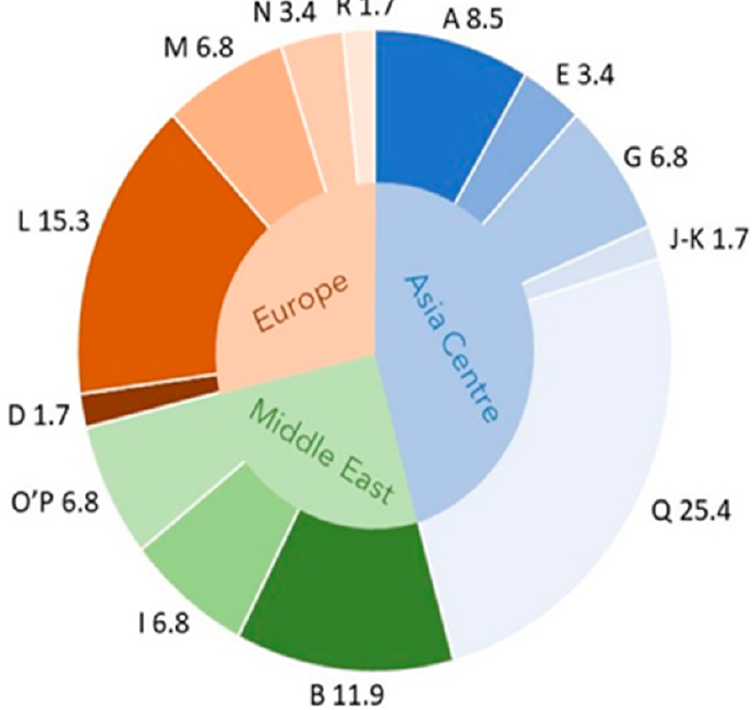
Figure 2. Percentage of haplogroup (A–R) composition (outer ring) of the Szekler horse according to the haplogroup most characteristic of the geographical areas (inner ring). In Central Asian horses marked in blue, haplogroups A, E, G, J–K, and Q are more common than in other horses. In the Szekler horse, these haplogroups are present with 45.8% of the total. By contrast, the haplogroups characteristic of European and Middle Eastern horses appear with 28.8 and 25.4% of the total, respectively. From these values, we proportionally infer the origin of the reconstructed stock of Szekler horse.